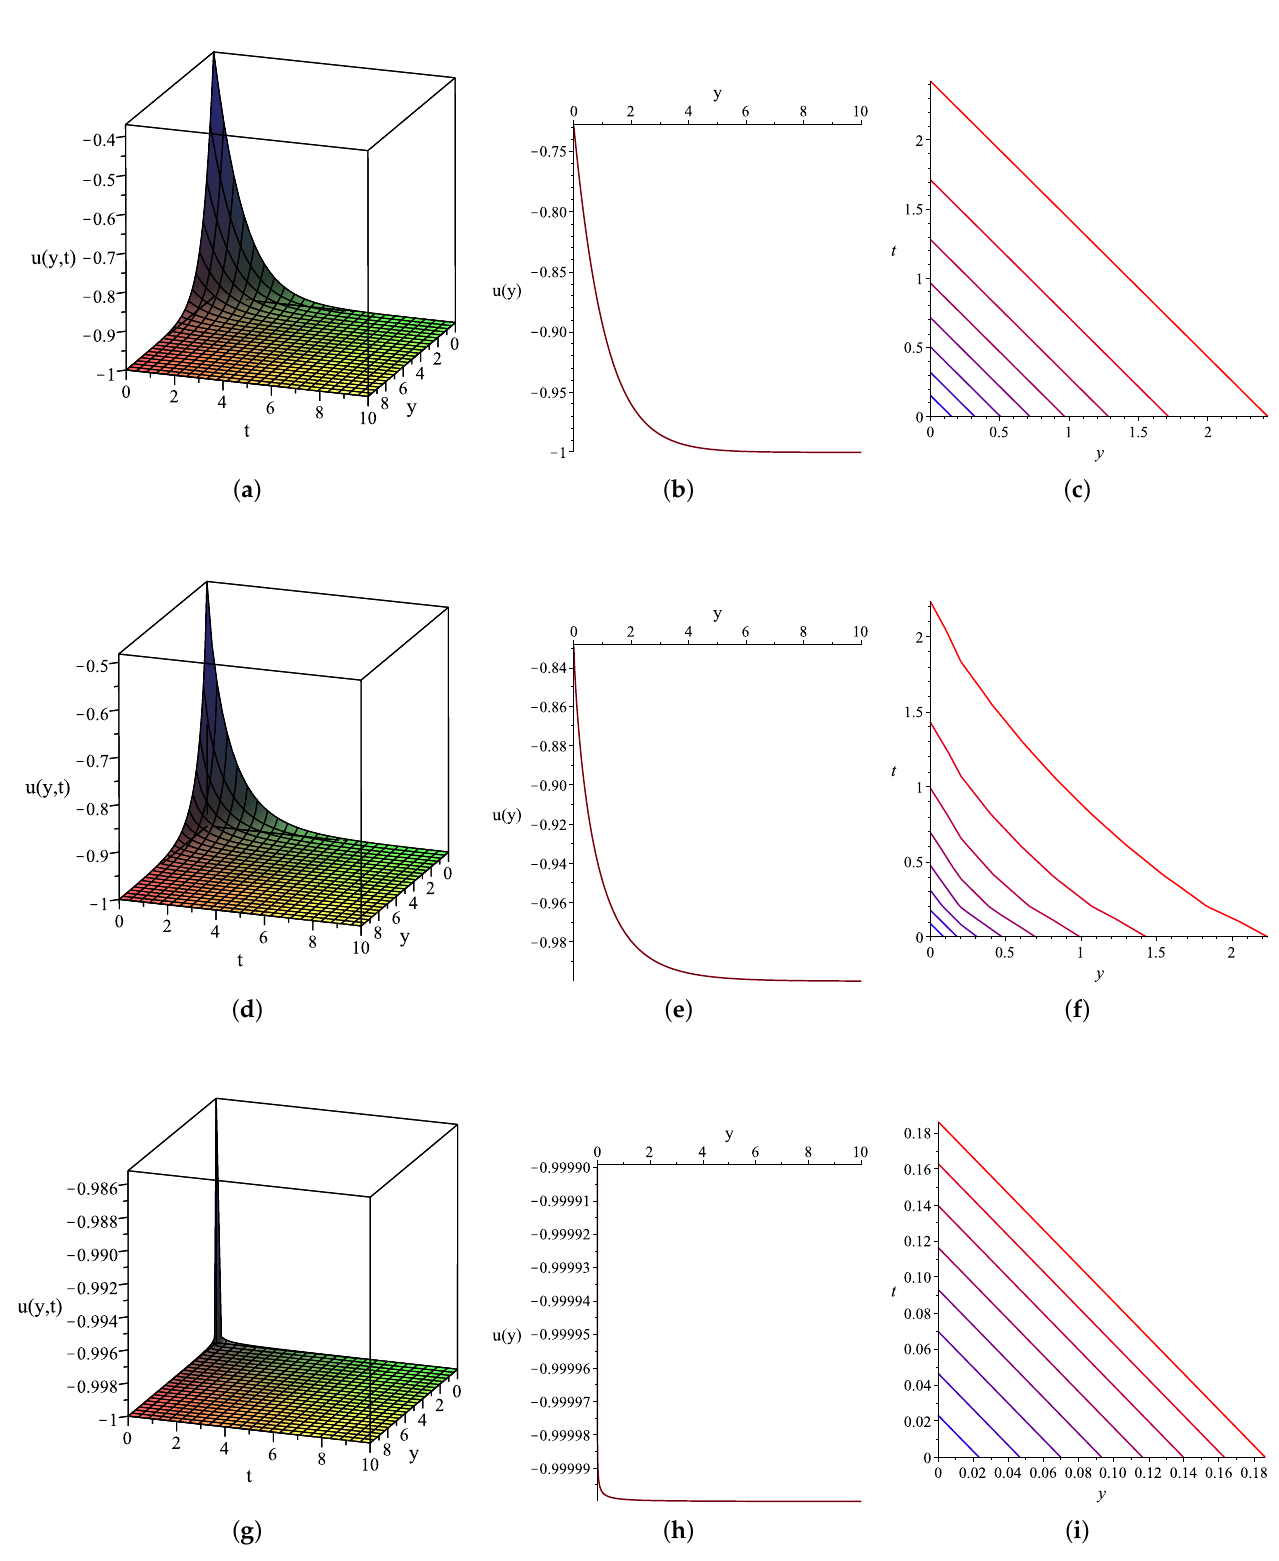
Figure 5. Associated plots of u 8 ( x , y , t ) in Equation (77) obtained using the auxiliary equation method: ( a – c ) 3-D plot, 2-D plot and contour plot, respectively when α = 1; ( d – f ) 3-D plot, 2-D plot and contour plot, respectively when α = 0.8; ( g – i ) 3-D plot, 2-D plot and contour plot, respectively when α =